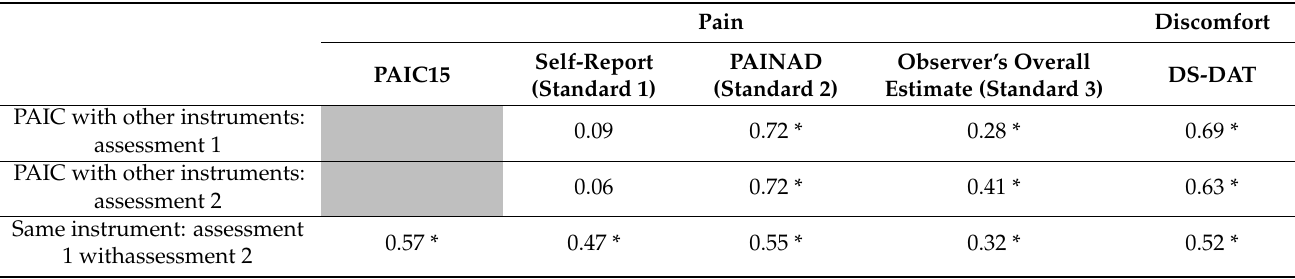
Table 5. Correlations (Spearman) of two assessments with, on average, 2.6 months in-between and correlations of PAIC15 with the pain standards and